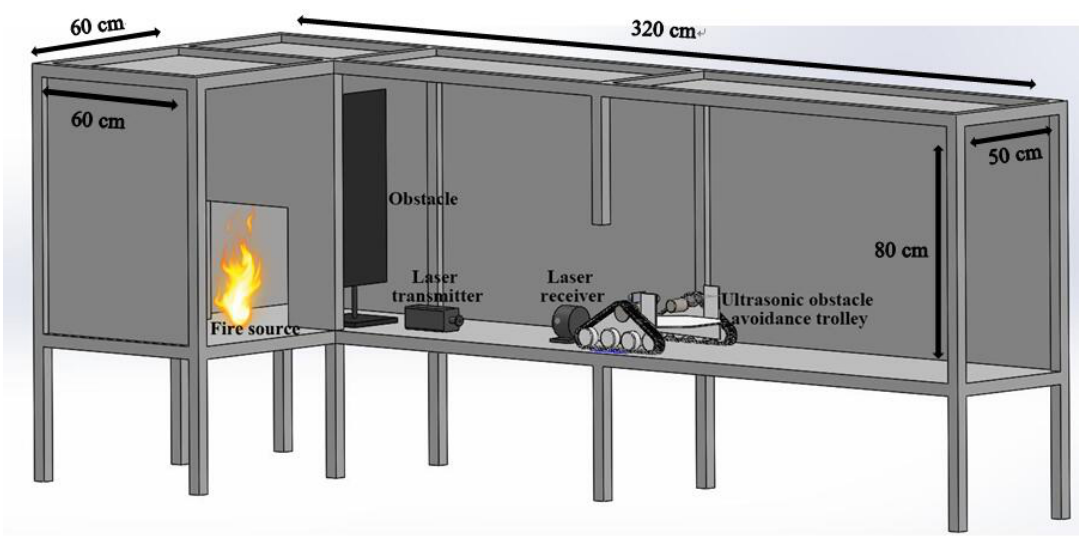
Figure 6. Schematic of reduced-scale test room model.